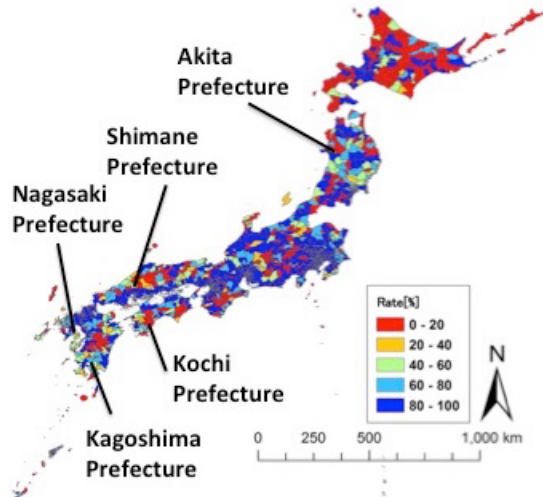
Figure 1. The map of point data of future population projection